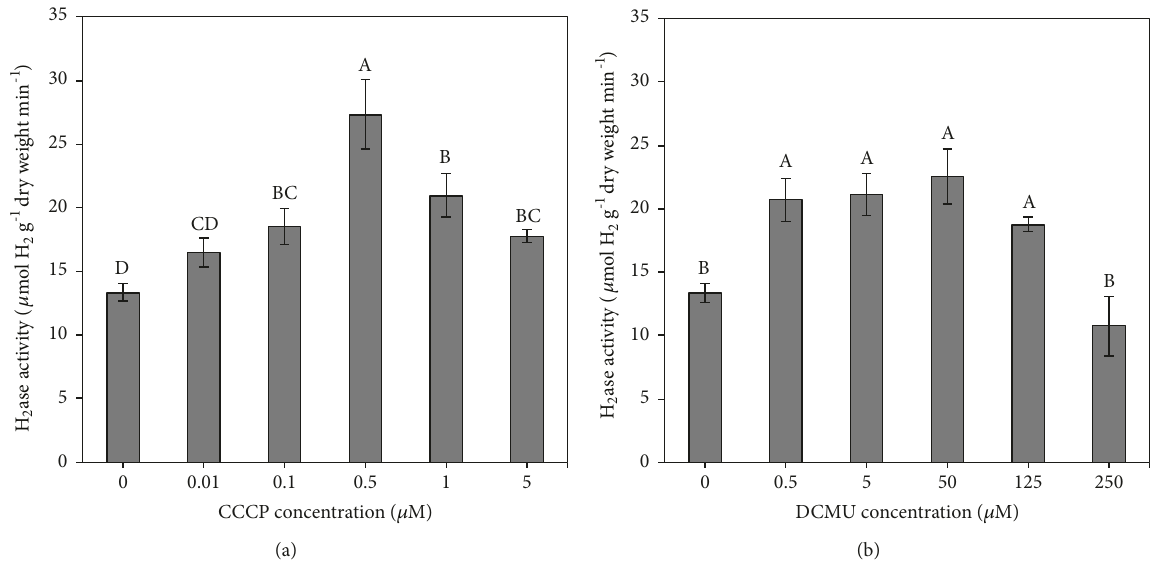
Figure 3: Effects of various concentrations of carbonyl cyanide m-chlorophenyl hydrazone (CCCP) (a) and 3-(3,4-dichlorophenyl)-1,1- dimethylurea (DCMU) (b) on bidirectional hydrogenase of Aphanothece halophytica after 2 hours of treatment under illumination. Data are means ± SD (n = 3). Different letters above columns indicate a significant difference according to Duncan’s multiple range test at p < 0.05.